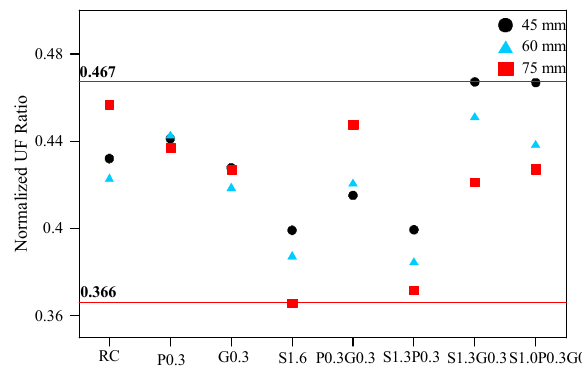
Figure 6. Ratio of normalized discs fracture energy to normalized cubes fracture energy for the eight mixtures.